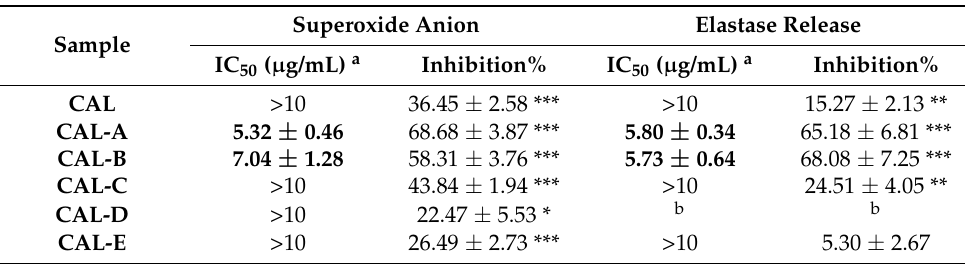
Table 4. Inhibitory effects of C. aethiopica leaf total methanol extract and its fractions on superoxide anion generation and elastase release in FMLF/CB-induced human neutrophils.